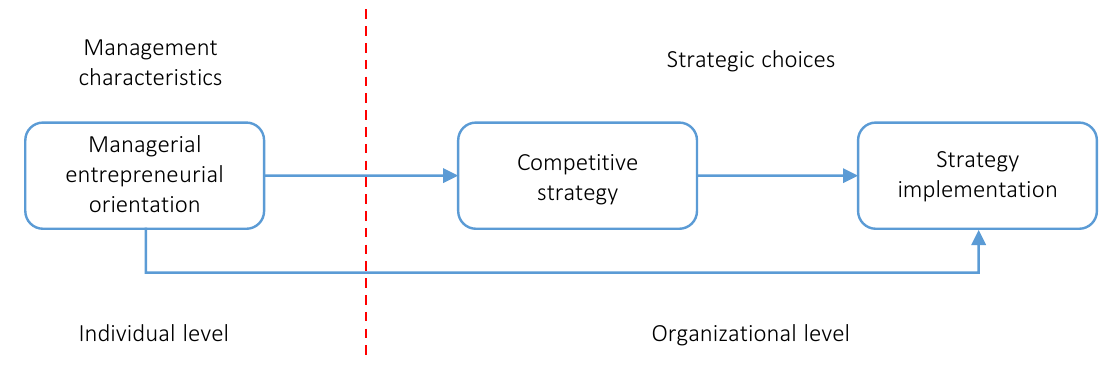
Figure 1. Research